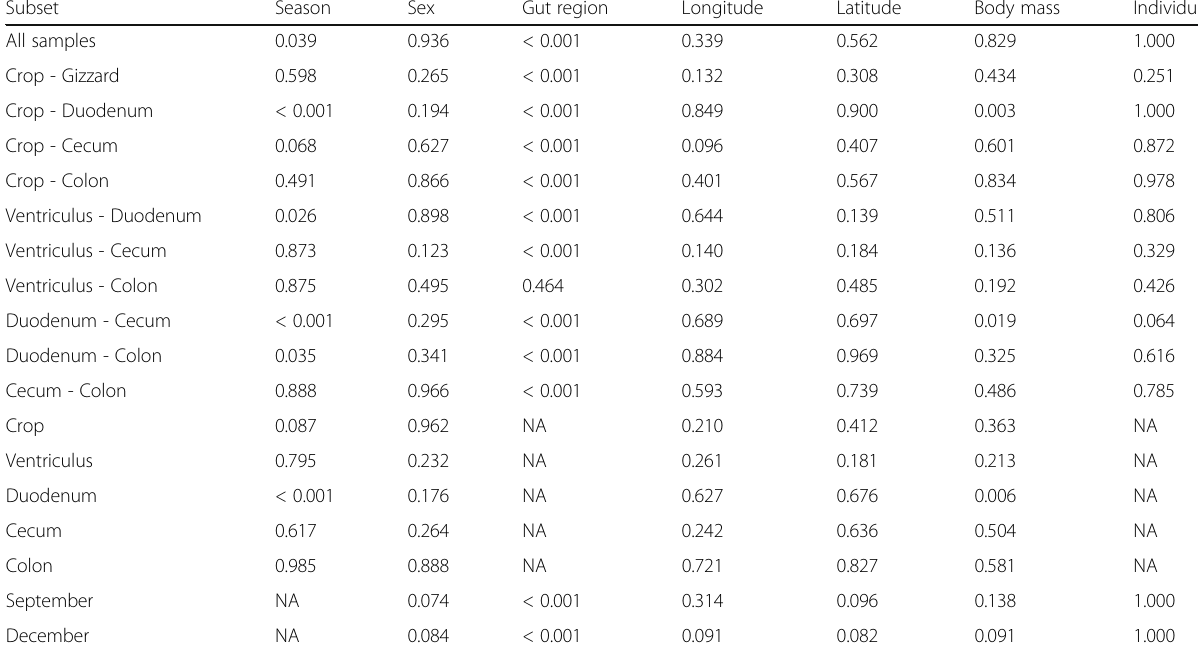
Table 2 P- values for log likelihood tests of linear mixed model regressions for relationships of observed number of OTUs with season, sex, gut region, geographic coordinates, body mass, and accounting for the matched design by individual. Complete outputs of statistical tests are presented in Additional file 6